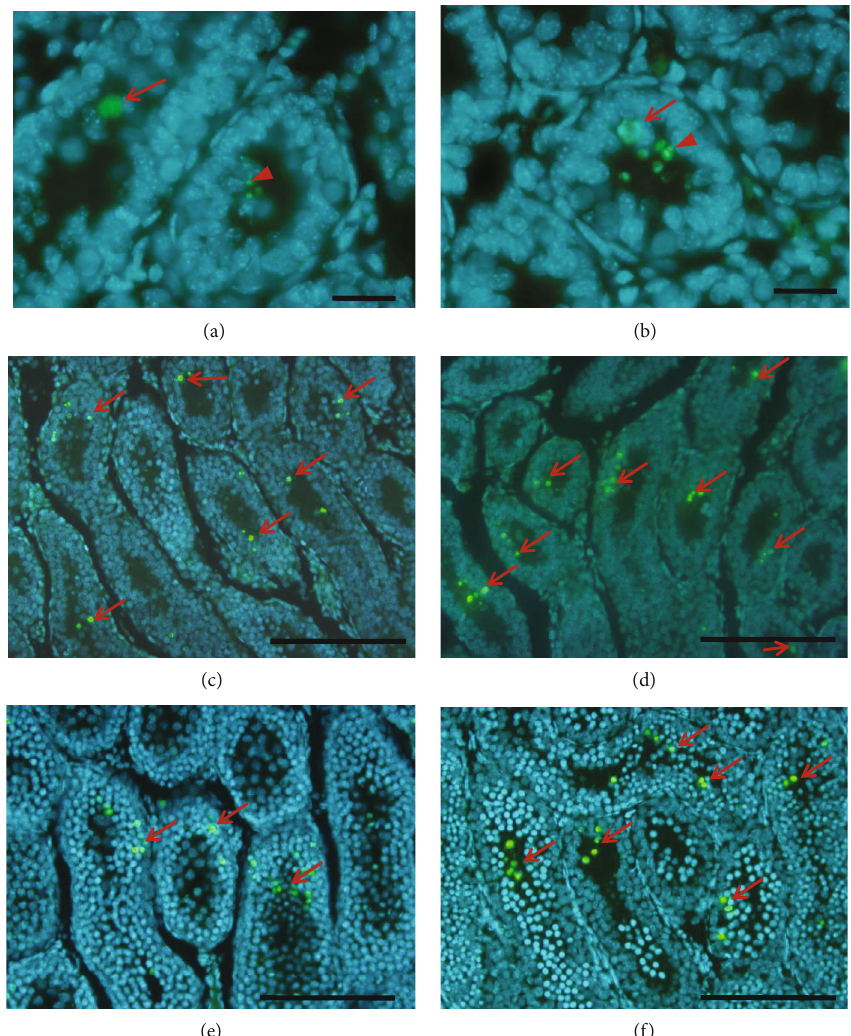
Figure 4: Seminiferous cords/tubules of mice: (a) Control of 3 dpp, (b) the nicotine group of 3dpp, (c) control of 10dpp, (d) the nicotine group of 10 dpp, (e) control of 16dpp, and (f) the nicotine group of 16dpp. Higher number of cells in apoptosis can be observed (arrow) in the seminiferous cords/tubules of mice with nicotine in comparison with the control group. Also, apoptotic bodies can be appreciated (arrowhead). TUNEL technique contrast with DAPI. (a, b) Bar scale: 20 μ m; (c – f) bar scale: 150 μ